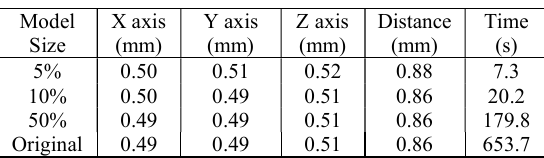
Table 2. 3D reconstruction errors (RMS) averaged over 35 consecutive poses for the femur.